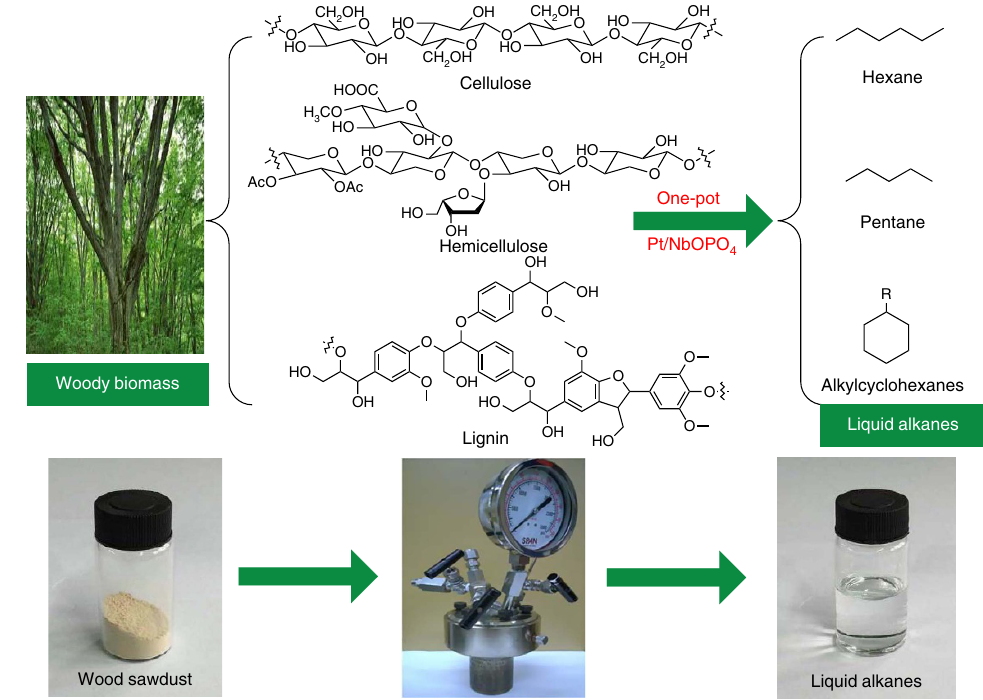
Figure 1 | Schematic representation of direct hydrodeoxygenation of raw woody biomass into liquid alkanes. Raw woody biomass can be directly converted into liquid alkanes over Pt/NbOPO 4 catalyst in cyclohexane medium, with cellulose, hemicellulose and lignin fractions in solid woods being converted into hexanes, pentanes and alkylcyclohexanes, respectively. Table 1 | Summary of direct hydrodeoxygenation of various woody biomass over Pt/NbOPO 4 .* Woody biomass Softwood Hardwood Pine White pine Larch Fir Camphor Birch Poplar Lignocellulose content Hemicellulose (wt%) 9.3